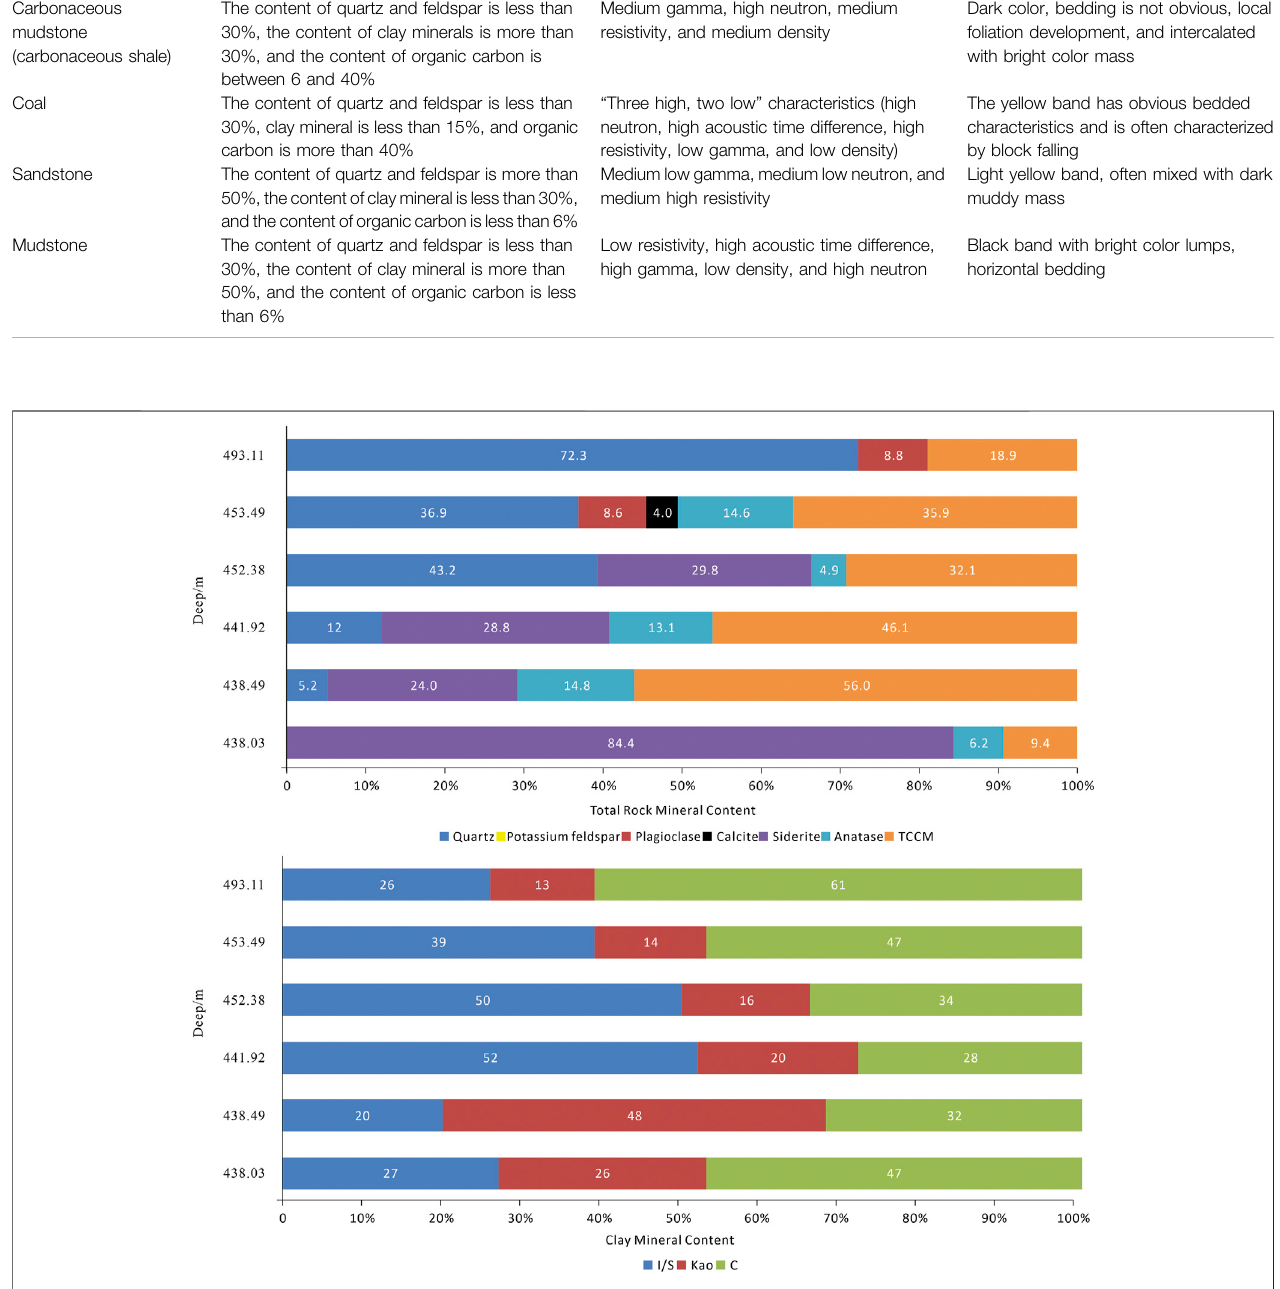
Frontiers in Earth Science |